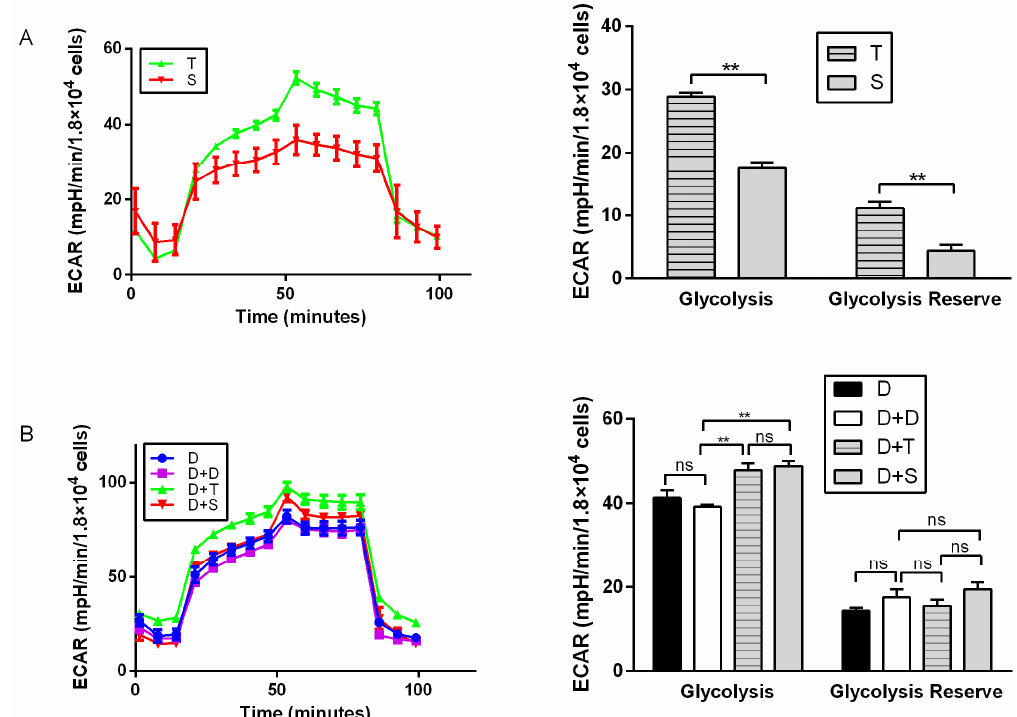
Figure 3. Glycolysis test for primary chicken cells and cybrids. ( A ) Illustrating ECAR of primary cell lines (T and S). ( B ) Illustrating ECAR of cybrids, D was used as a control for D + D. All cells exposed sequentially to glucose, oligomycin, and 2-DG. ECAR profiles were expressed as mpH / min / 1.8 × 10 4 cells. n = 6 per group. ** means p < 0.01 and ns means p > 0.05.